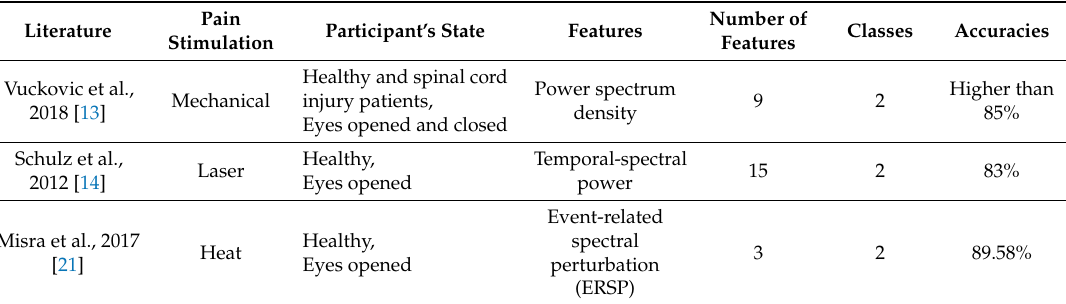
Table 1. Classification accuracies of EEG for di ff erent pain